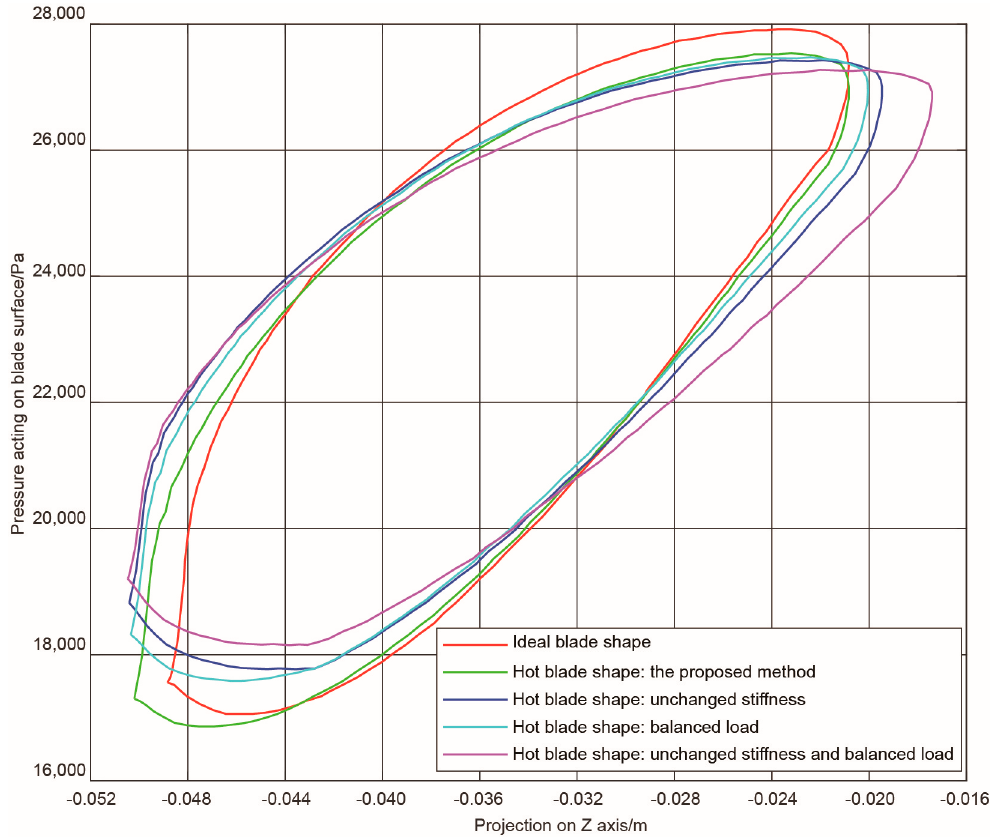
Figure 13. Pressure curves of the cross-sectional edge at 50% of the blade height.